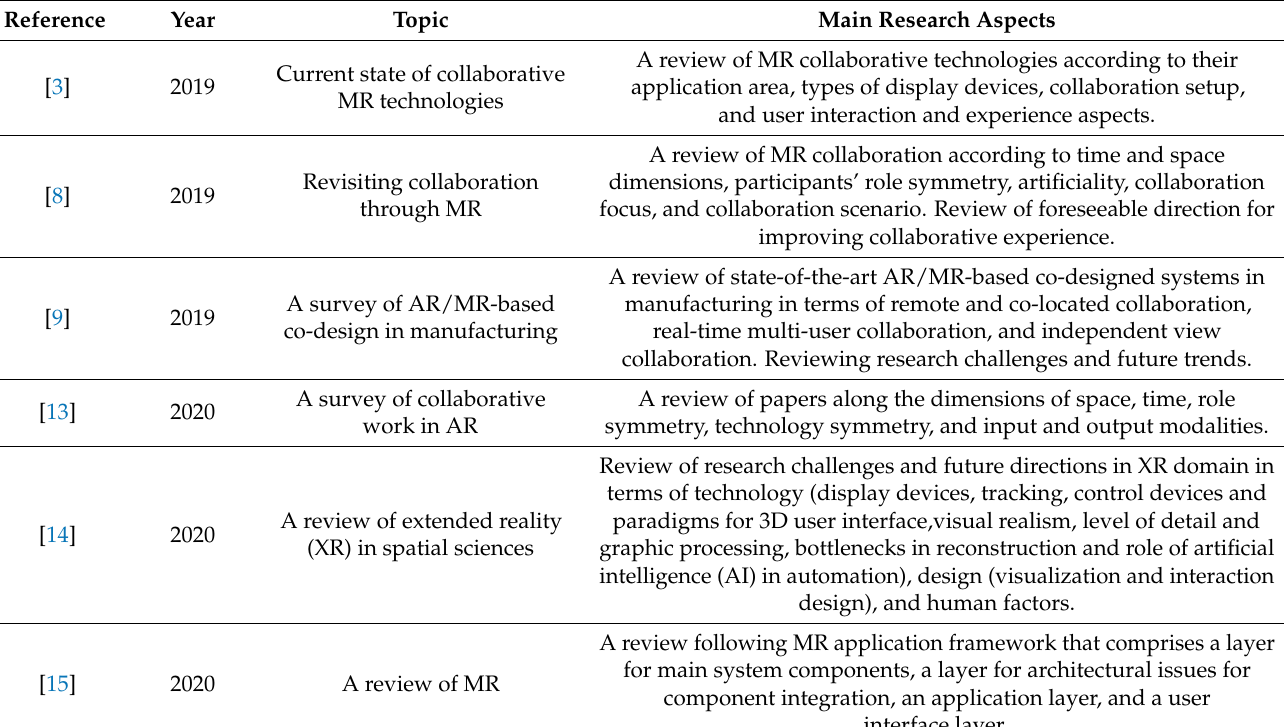
Table 1. Related